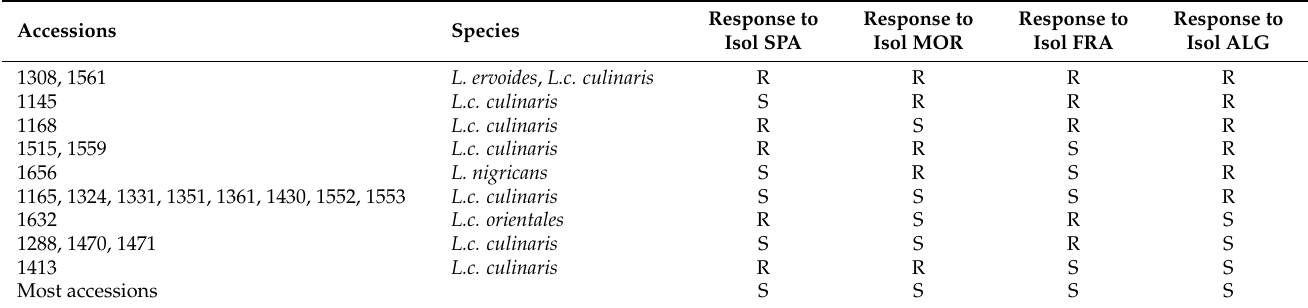
Table 6. Summary of responses identified against the four rust isolates studied showing clear isolate- specific responses corresponding to minimum four races, with sources of resistance to each